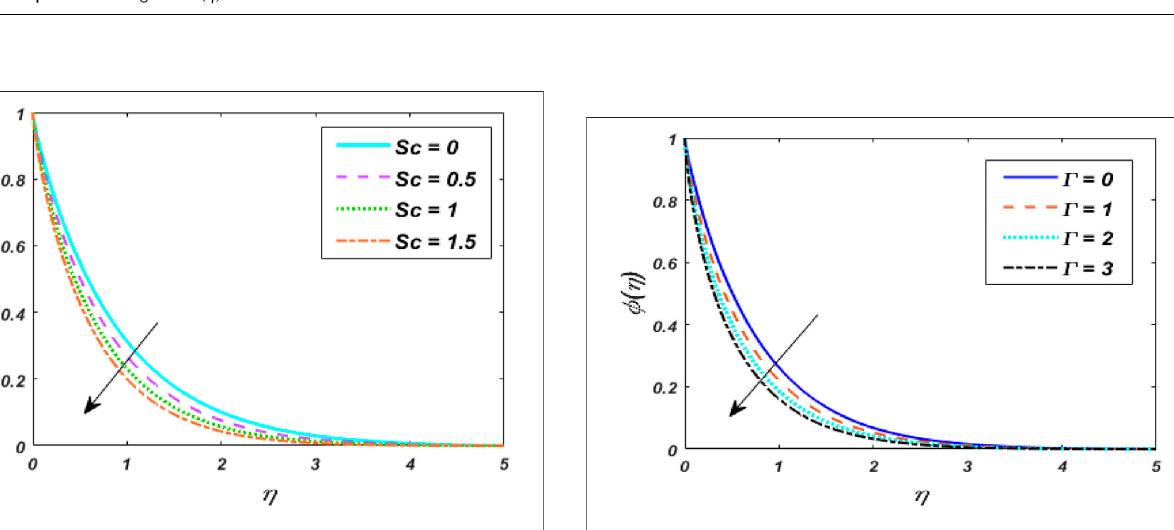
FIGURE 8 | Nt and Nb against θ ( η ) .